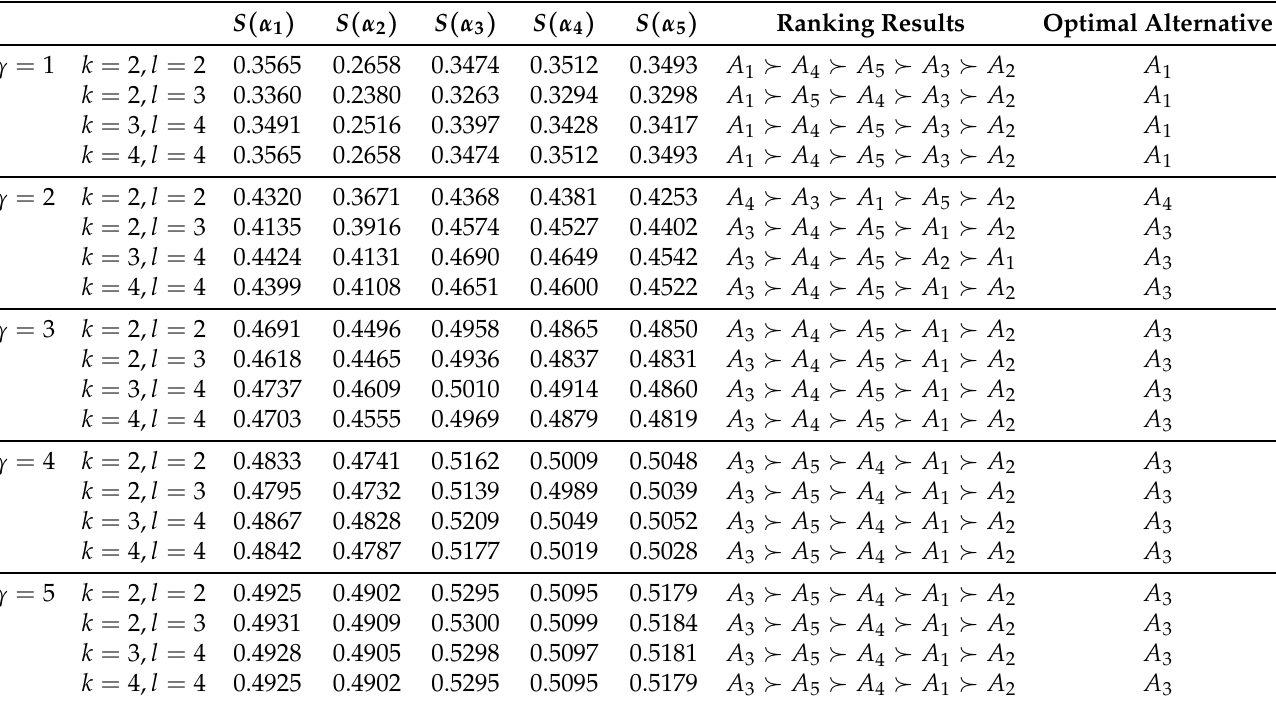
Table 7. Ranking results of the TSFWDBM operator.